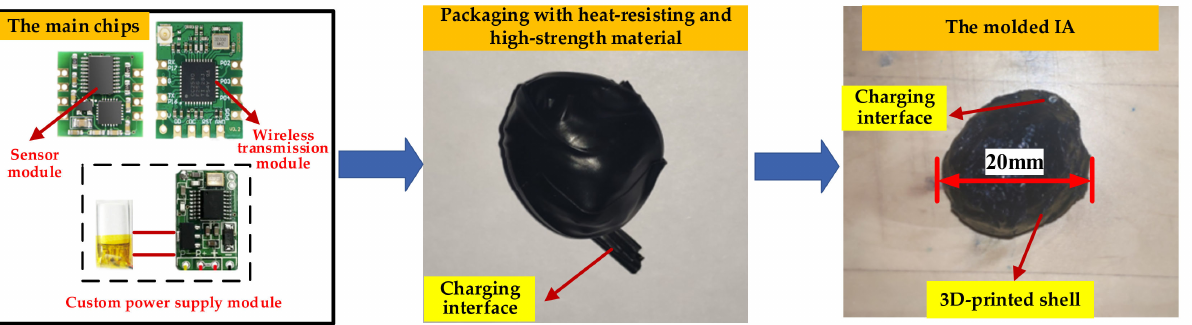
Figure 3. Preparation process of